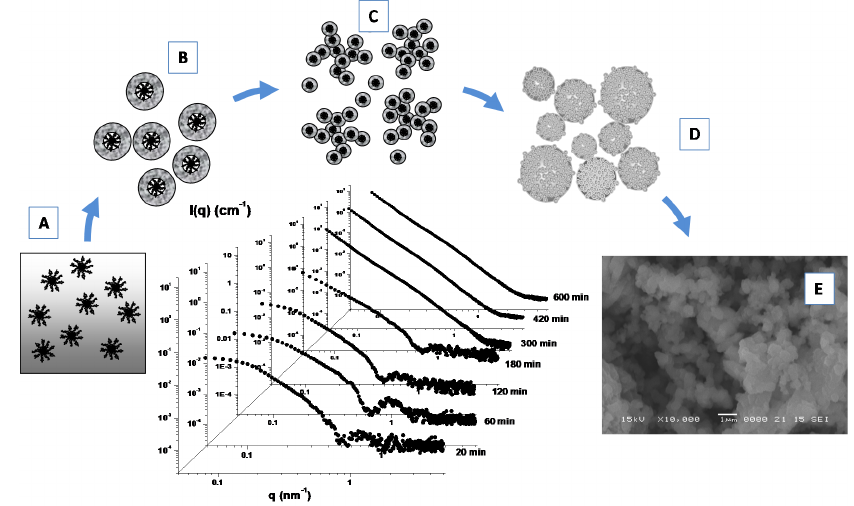
Figure 8. SAXS time evolution and formation of porous Linde type A (LTA) zeolite nanostructures